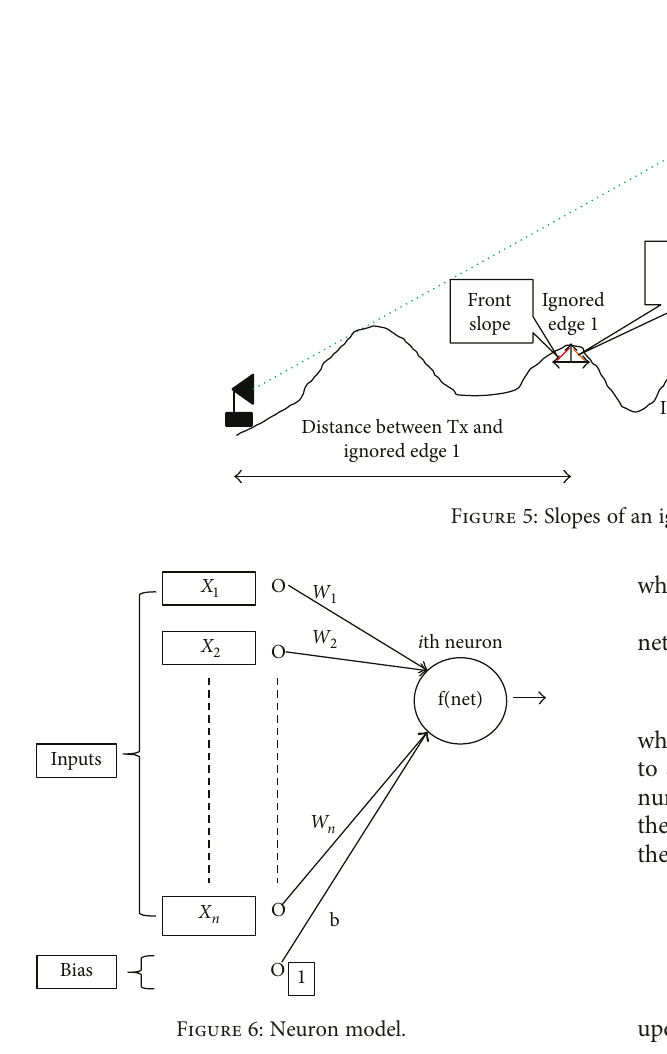
Figure 6: Neuron